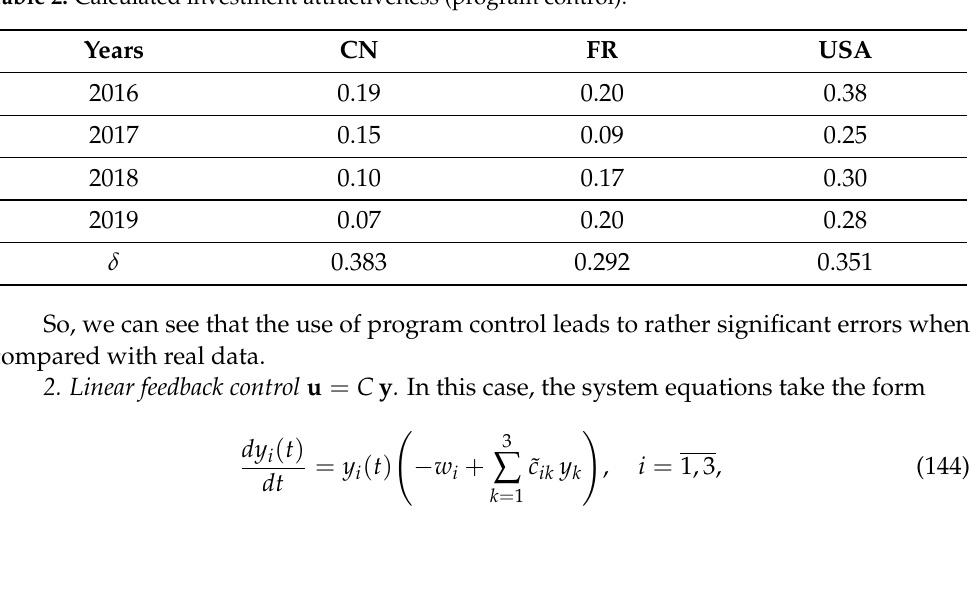
Table 2. Calculated investment attractiveness (program